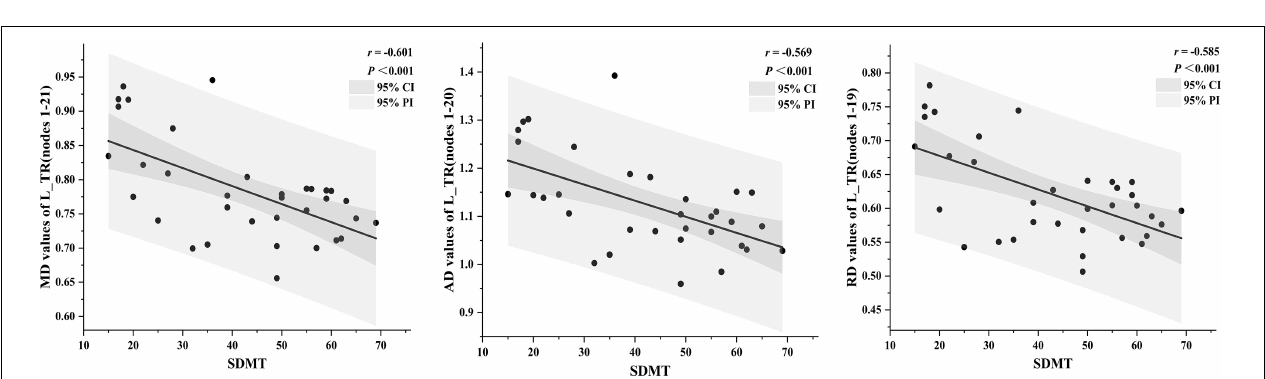
FIGURE 6 | The correlations between diffusion tensor imaging (DTI) metrics and clinical cognitive performance [ p < 0.05, false discovery rate (FDR) correction]. The dark gray region represents the 95% confidence interval (CI), and the light gray region represents the 95% prediction interval (PI). SDMT, symbol digit modalities test.